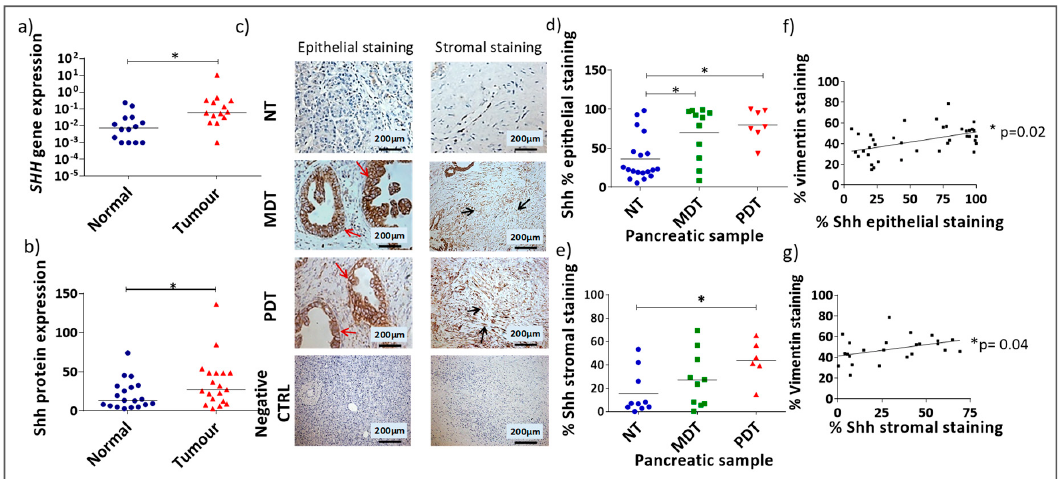
Figure 1. Shh is overexpressed in PDAC in the epithelial and stromal compartments: ( a ) SHH gene expression in tumour tissues compared to paired normal tissues (* p < 0.05 Wilcoxon matched-pairs signed rank test). ( b ) Quantification of IHC staining (H-score) for Shh protein expression in normal and tumour tissues (* p < 0.05 Wilcoxon matched-pairs signed rank test). ( c ) Example images of Shh IHC staining in normal pancreatic tissue (NT), and moderately differentiated pancreatic tumour (MDT), and poorly differentiated pancreatic tumour (PDT) tissues. Negative controls demonstrate the absence of staining either in normal tissue (column on the left) or PDT tissue (column on the right) when an isotype control antibody was substituted for the specific antibody to the target. Red arrows show epithelial Shh expression and black arrows show stromal Shh expression. Semi-quantitative analysis of the percentage Shh staining in the epithelial ( d ) and stromal ( e ) compartments (* p = < 0.05 Kruskal-Wallis multiple comparison Test) for NT, MDT, or PDT samples. Analysis of correlation (Spearman correlation test) between % vimentin staining and % epithelial (* p = 0.015) ( f ) or stromal (* p = 0.04) ( g ) Shh staining.